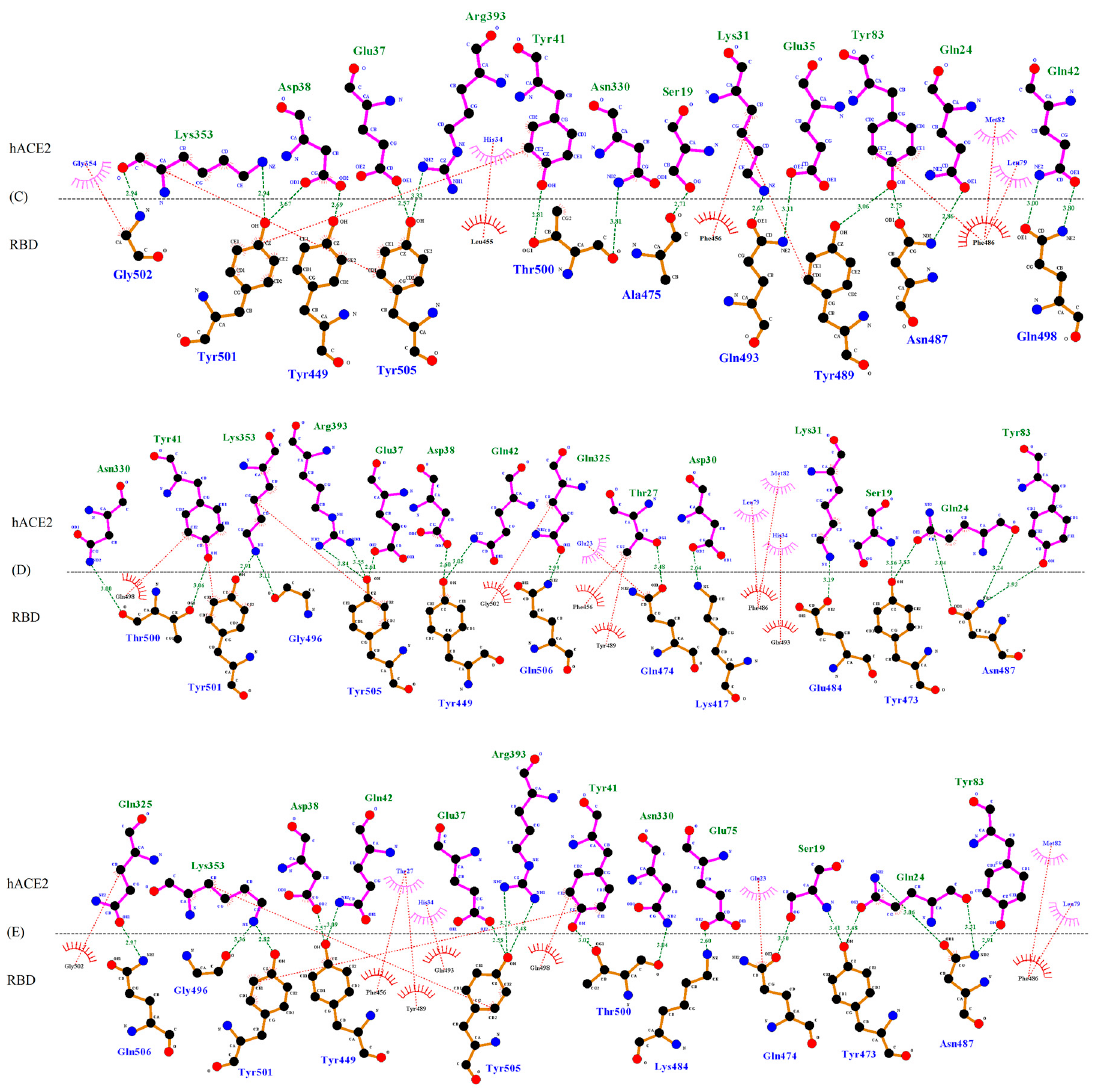
Figure 2. Interacting amino acids between ( A ) WT RBD-hACE-2; ( B ) UK-VOC RBD-hACE-2; ( C ) SA-VOC-RBD-hACE-2; ( D ) COH-VOC-RBD-hACE-2; ( E ) BR-VOC-RBD-hACE-2. The models were analyzed for interactions using DIMPLOT tool implemented in Ligplot+ v.2.2.4. The H-bond/salt-bridge and hydrophobic interactions are shown with green and red dots, respectively.